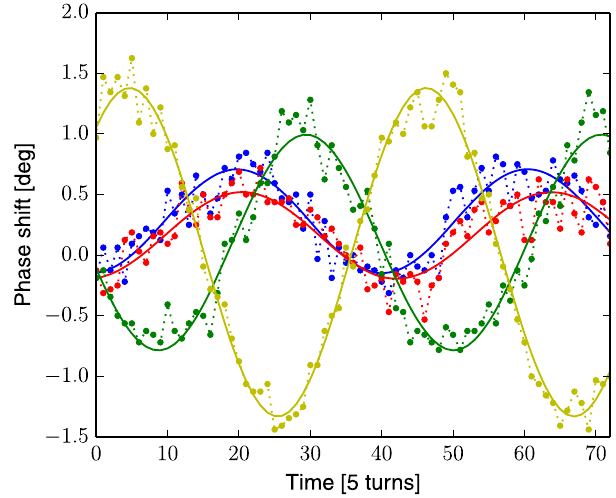
FIG. 8. Vector representation of the error introduced by the residual offsets of the I and Q components of the bunch signal for ¼ 0 . The original vector A 0 (black) is defined from the case φ PM the real origin O to the end of the measured vector A (blue). The phase error δφ is the angle between A 0 and A , and it depends on j A j , j A j and θ 0 o as defined in Eq. (9). o